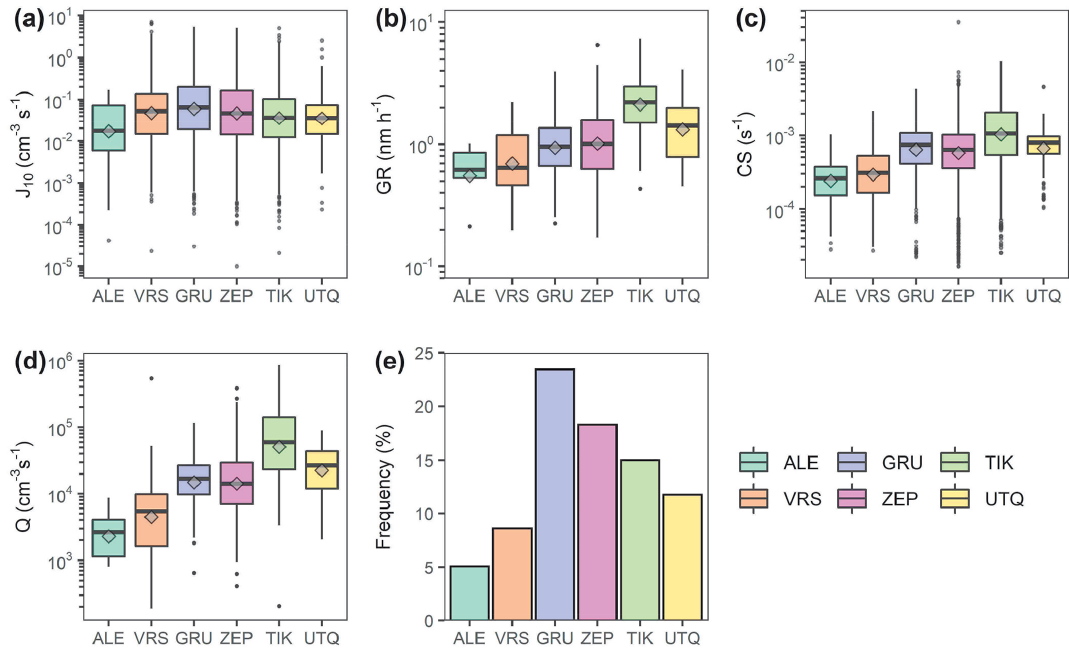
Figure 3. Characteristics of NPF events per site in the months of May through August inclusive, showing (a) formation rates at 10nm, (b) growth rates, (c) condensation sinks, (d) vapour source rates, and (e) NPF event frequency. Box plots show median (centre line), mean (diamond), upper and lower quartiles (box limits), 1.5 times the interquartile range (whiskers), and any outliers as points. Colours represent each